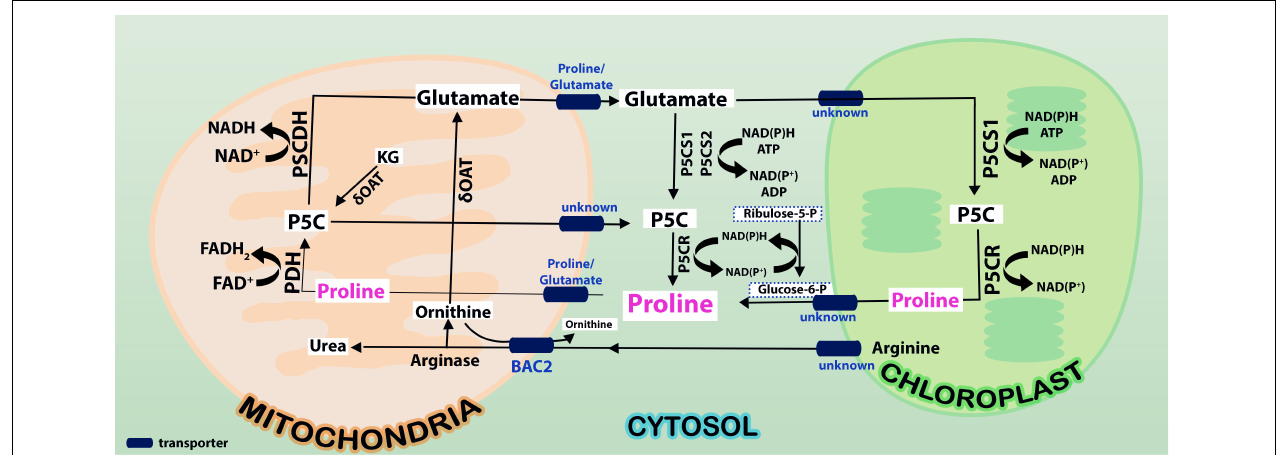
FIGURE 1 | Proline is synthesized from glutamate in cytosol by P5CS1/P5CS2 enzymes and these reactions take place in cytosol (indicated in yellow shade). Oxidation of proline takes place by ProDH and P5CDH enzymes in mitochondria (indicated in green shade). While proline synthesis consumes NAD(P)H and ATP in cytosol, its degradation releases FADH 2 and NADH in mitochondria. It is not clearly known what transports arginine and ornithine from cytoplasm into mitochondria. But, it is predicted that arginine and ornithine, the two polyamines are transported into mitochondria from cytosol and back by basic amino acid carriers (BAC2). While arginine gets converted to ornithine, ornithine is catalyzed by ornithine δ -amino transferase (OAT) to pyrroline-5-carboxylate (P5C), an overriding intermediate in proline cycle. Note that the release of NAD(P)H is connected to pentose phosphate pathway (PPP pathway) in mitochondria. Conversion of P5C to proline and proline to P5C changes the NADP + /NADPH ratio in the cells. This leads to the modulation of phosphoribosyl pyrophosphate (PRPP) synthesis besides nucleotide biosynthesis via the PPP pathway.